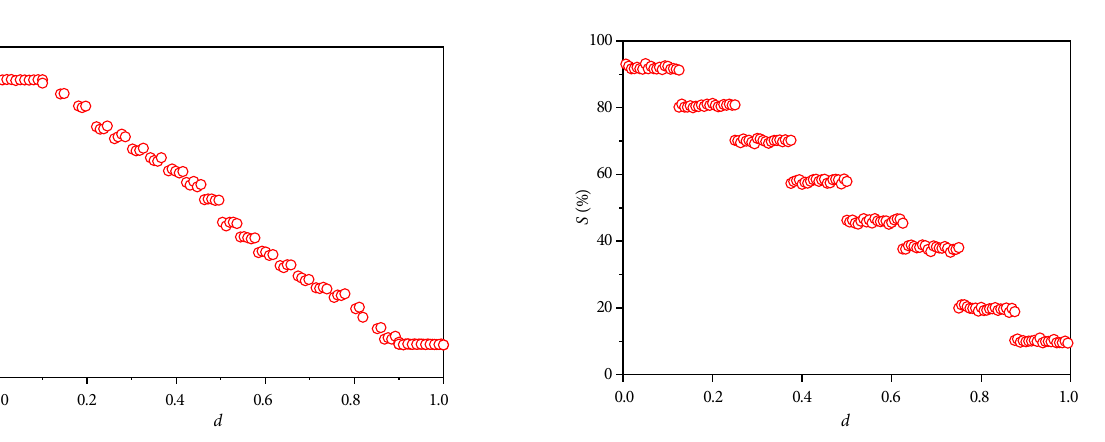
Figure 6. Cascade scale and threshold value d Figure 7. Cascade scale and threshold value